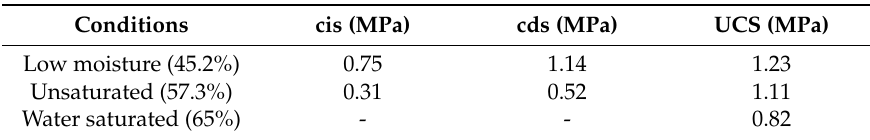
Table 7. Stress threshold values of different moisture content samples.